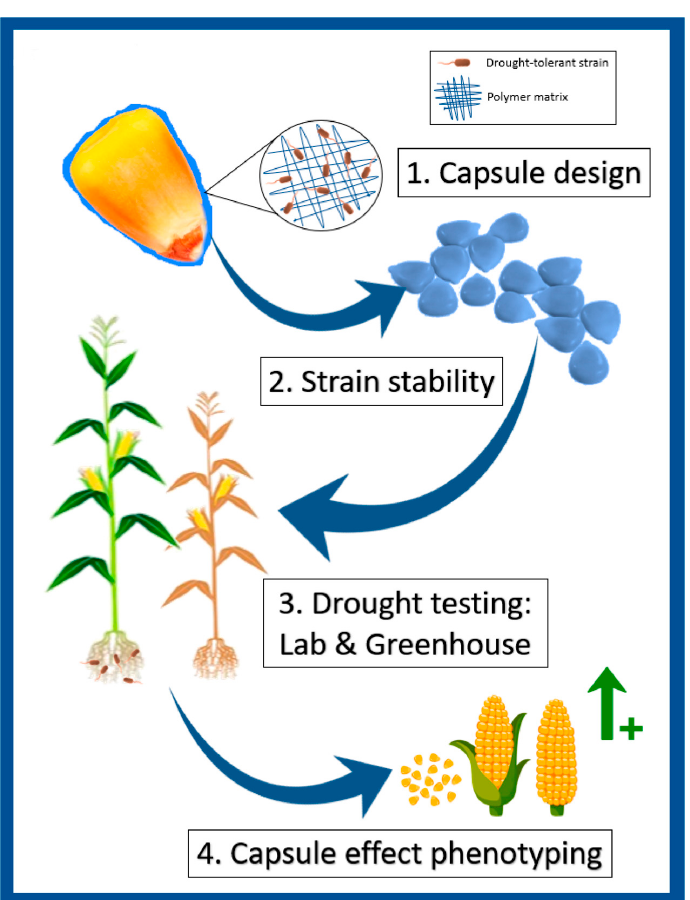
Figure 7. Evaluation workflow for new capsules bioformulation in maize. Schematic description of the preparing, application and evaluation process for dry capsule bioformulation with xerotoler- ant